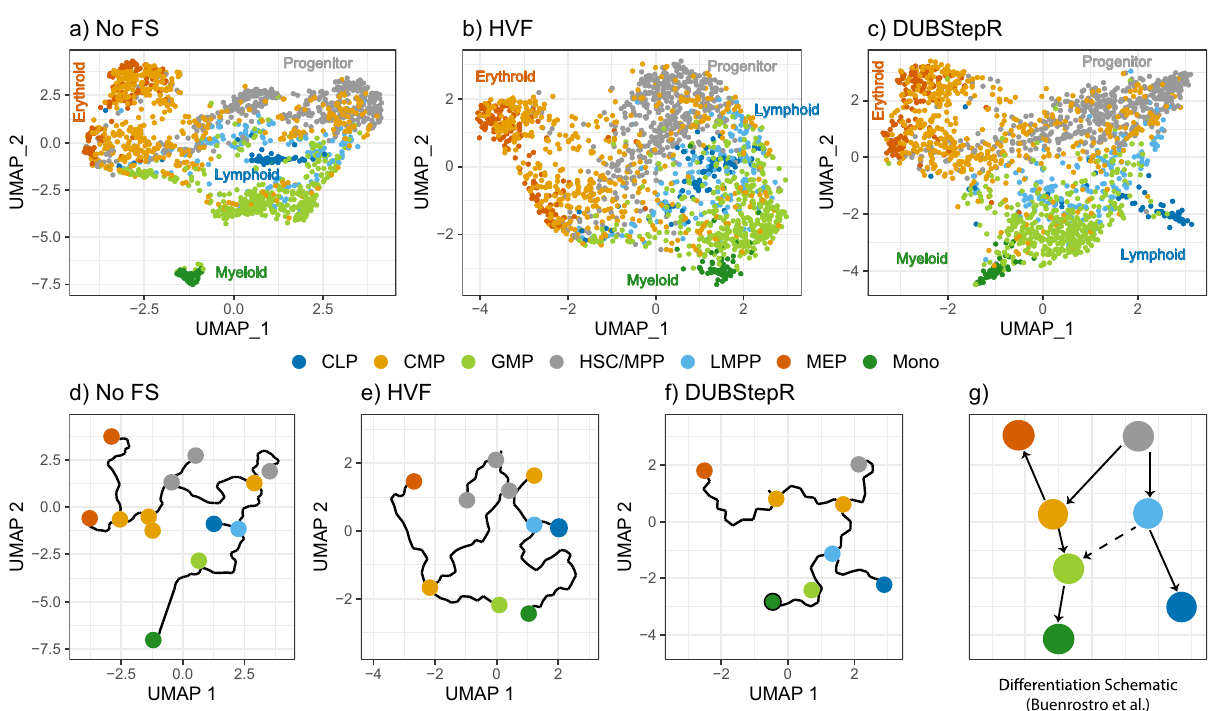
Fig. 7 Comparison of feature selection on scATAC-seq data from Buenrostro et al. 27 . a – c UMAP visualizations of cells colored by FACS-sorted cell type labels, with trajectories constructed using Monocle 3. a All peaks (no feature selection), b peaks selected by highly variable features (HVF), c peaks selected by DUBStepR. d – f Monocle-generated trajectories on the corresponding UMAP visualizations. g Hematopoietic differentiation schematic. CLP common lymphoid progenitor, CMP common myeloid progenitor, GMP granulocyte/macrophage progenitor, HSC hematopoietic stem cell, LMPP lymphoid-primed multipotent progenitor, MEP megakaryocyte/erythroid progenitor, Mono monocyte, MPP multipotent